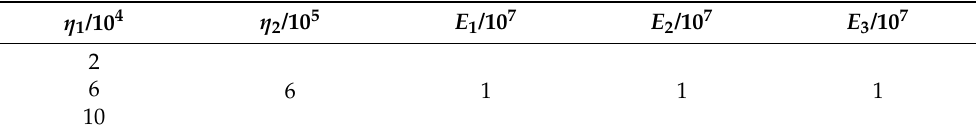
Table 2. η 1 as variable.